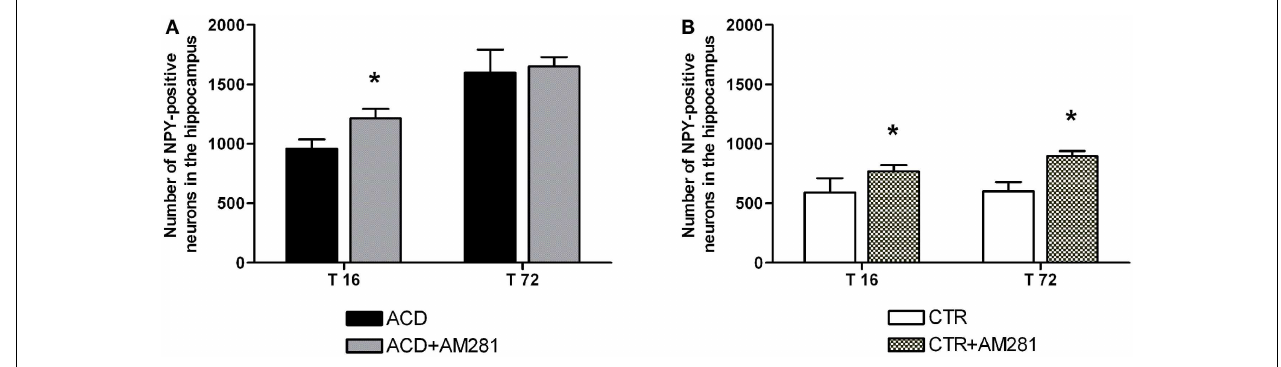
FIGURE 4 | Effect ofAM281 treatment on the number of hippocampus neuropeptideY (NPY)-positive neurons inACD rats (A) and in controls (B) . Each value represents the mean ± S.D. of 12 sections for each experimental condition. * p < 0.001 vs respective